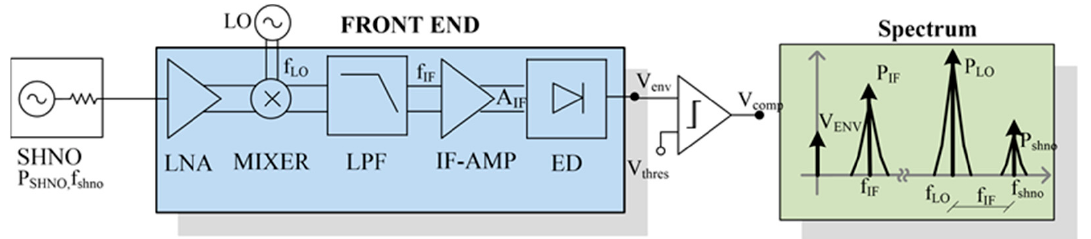
Figure 3. Frond-end scheme proposed to sense the SHNO output signal.